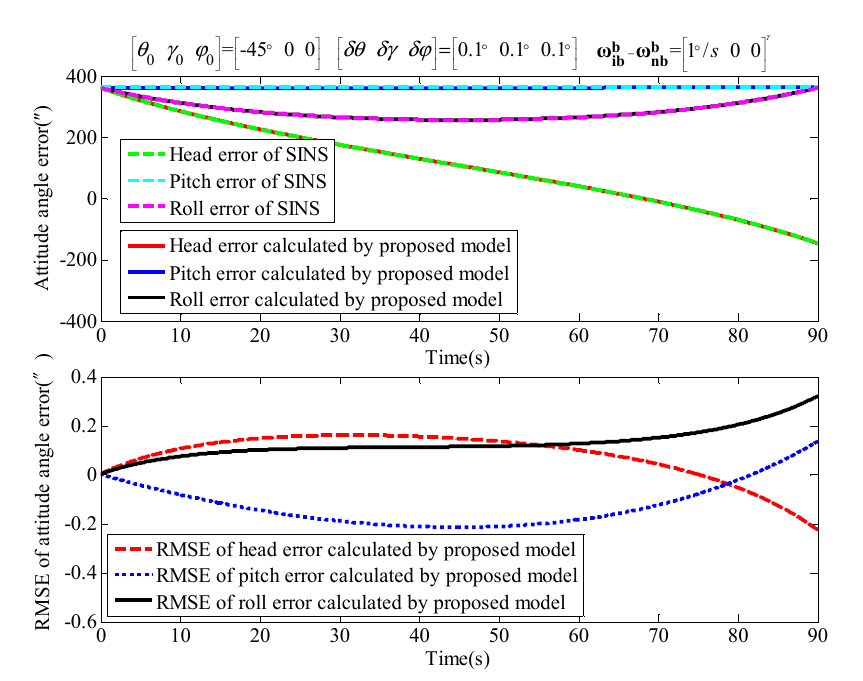
Figure 8. The Euler angle error propagation with coupling of three initial Euler angle errors and rotation in the X axis.